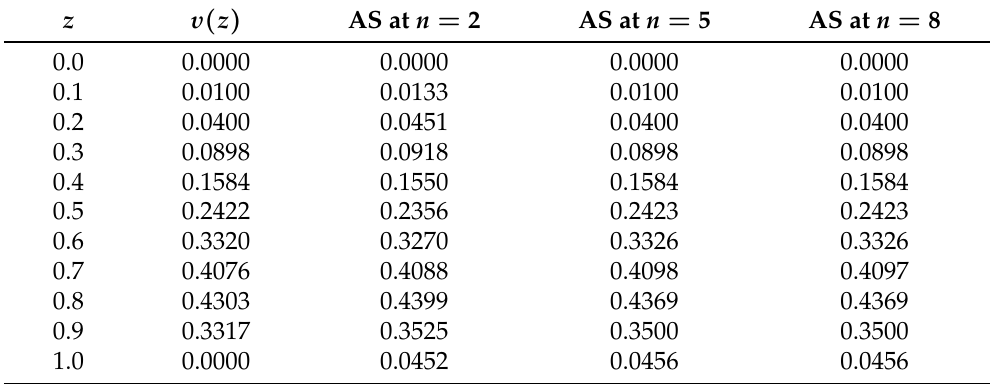
Table 10. Comparison of exact solution with approximate solution (AS) at m = 2, 5 and 8 in Example